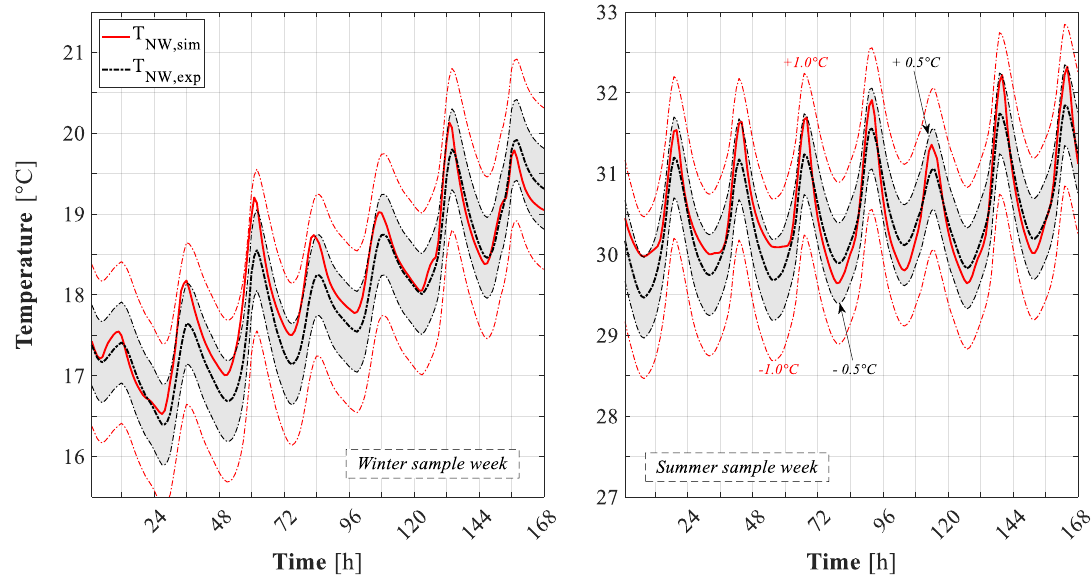
Figure 15. North-West wall temperature: simulated vs. experimental results (two sample weeks).